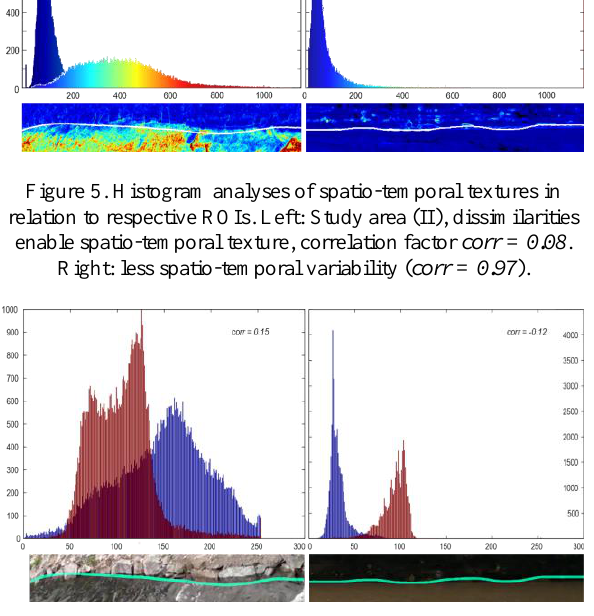
Figure 6. Histogram analysis of average image in respect of respective ROIs. Left: gray level distribution of mean values provides no useful information for image segmentation. Right: Study area (III), classifiable due to homogenized image content by averaged gray values.